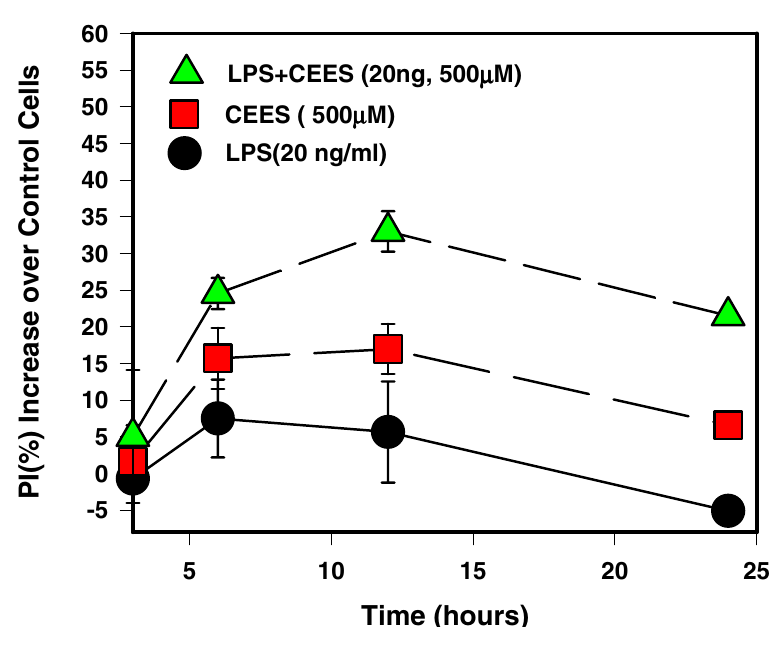
Cell viability as a function of time. RAW 264.7 macrophages were treated with LPS alone, CEES alone or a combination of both LPS and CEES. Cell viability was assayed with the propidium iodide (PI) assay as described in the Methods.